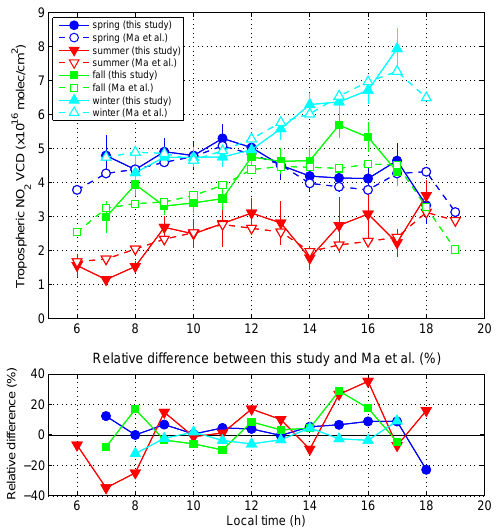
Fig. 5. Comparison of seasonally averaged tropospheric NO 2 VCD diurnal variations from MAX-DOAS measurements performed at the Institute of Atmospheric Physics (present study) and at the China Meteorological Administration (Ma et al., 2013) in the Bei- jing city centre. The period covered by the observations is August 2008–April 2009. Ma et al. (2013) is taken as reference for the calculation of relative differences. The calculated mean biases are: + 3 ± 9% in spring, + 3 ± 20% in summer, + 4 ± 12% in fall, and − 2 ± 6% in winter.